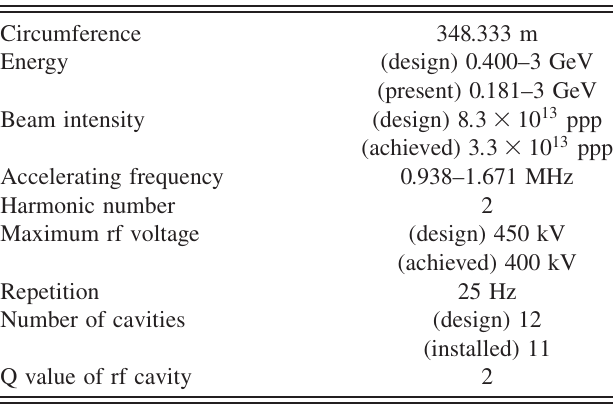
TABLE I. Parameters of the J-PARC RCS and its rf